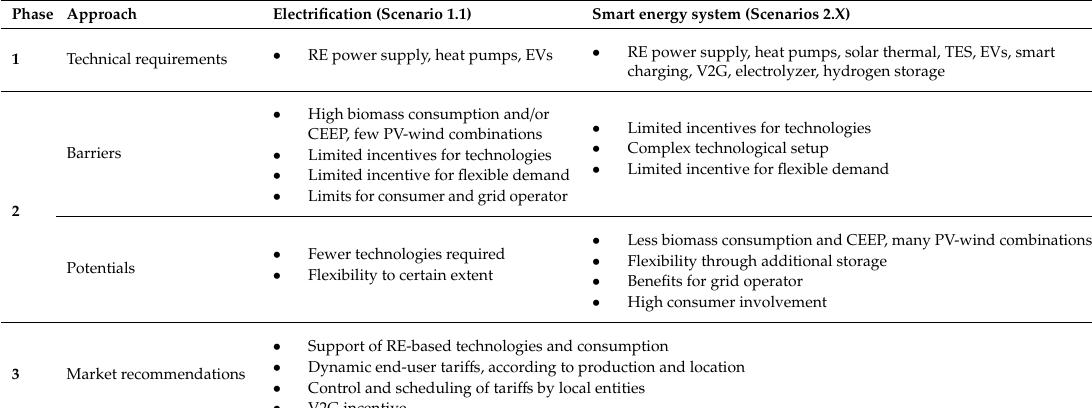
Table 2. Overview of the phases of the institutional analysis in relation to the technical analysis. Phase